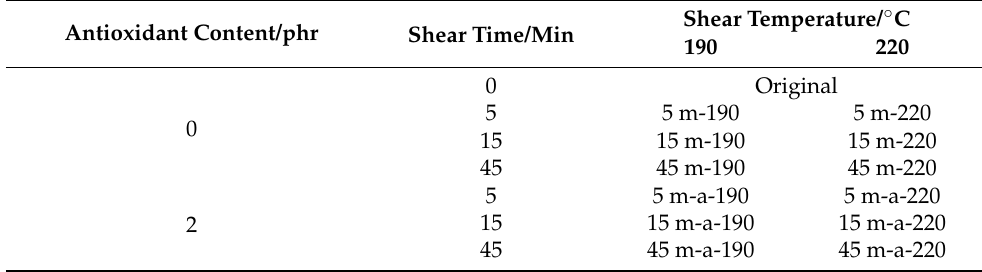
Table 1. Sample number and shear